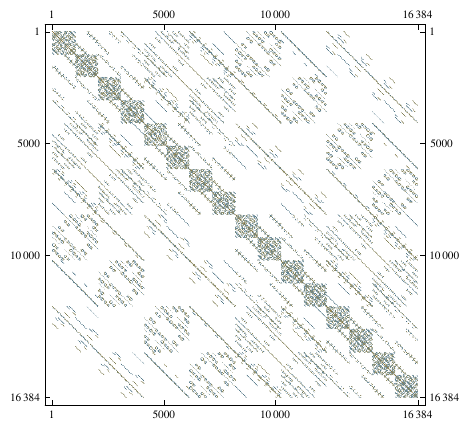
Figure 1 . MatrixPlot of the Hamiltonian